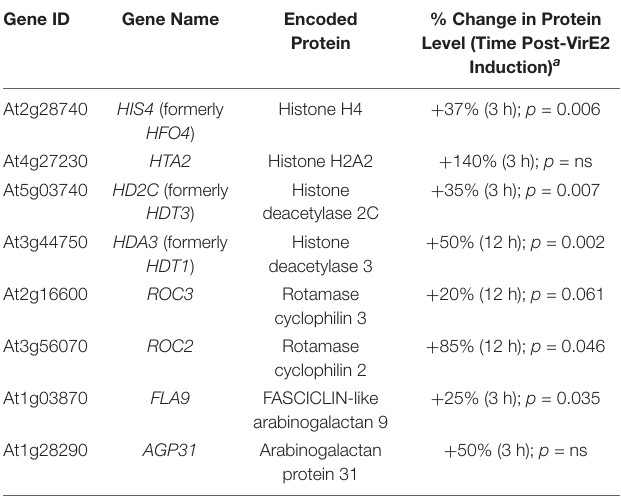
TABLE 5 | Transformation phenotypes of A. thaliana lines containing overexpression constructs of genes whose proteins show increased abundance post-VirE2